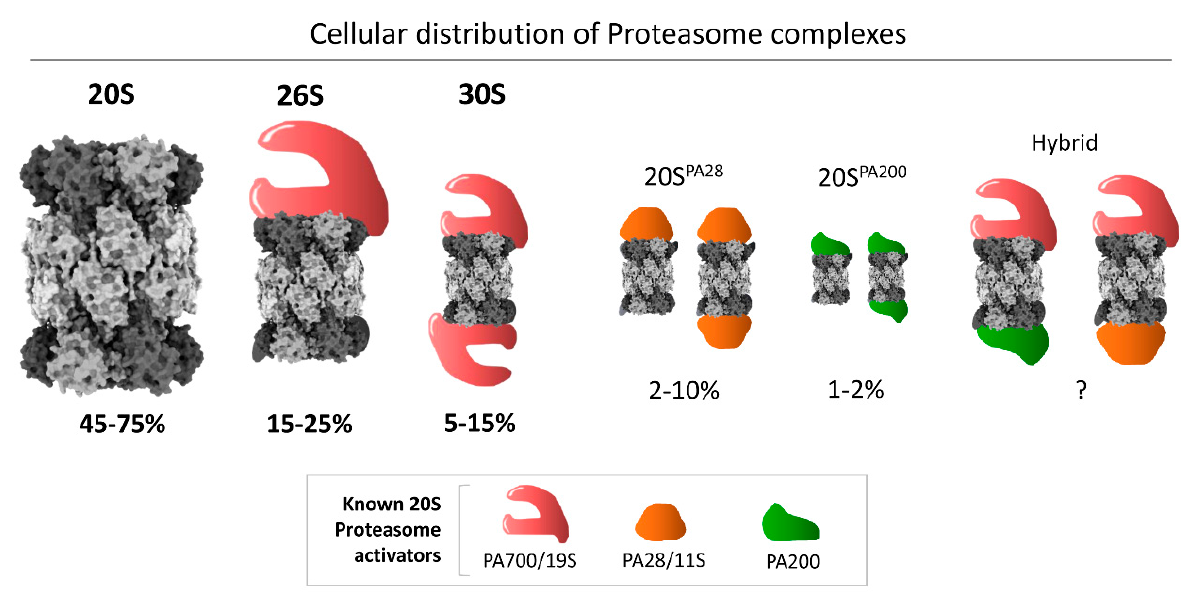
Figure 1. Cellular distribution of different proteasome complexes in mammalian cells. The 20S model figure was generated by ChimeraX using the 20S cryo-EM structure [49]. The average percentages are calculated based on published reports [3]. The size of each proteasome species corresponds to the average value of the range denoted to visually illustrate their relative abundance in cell lines that have been quantified.